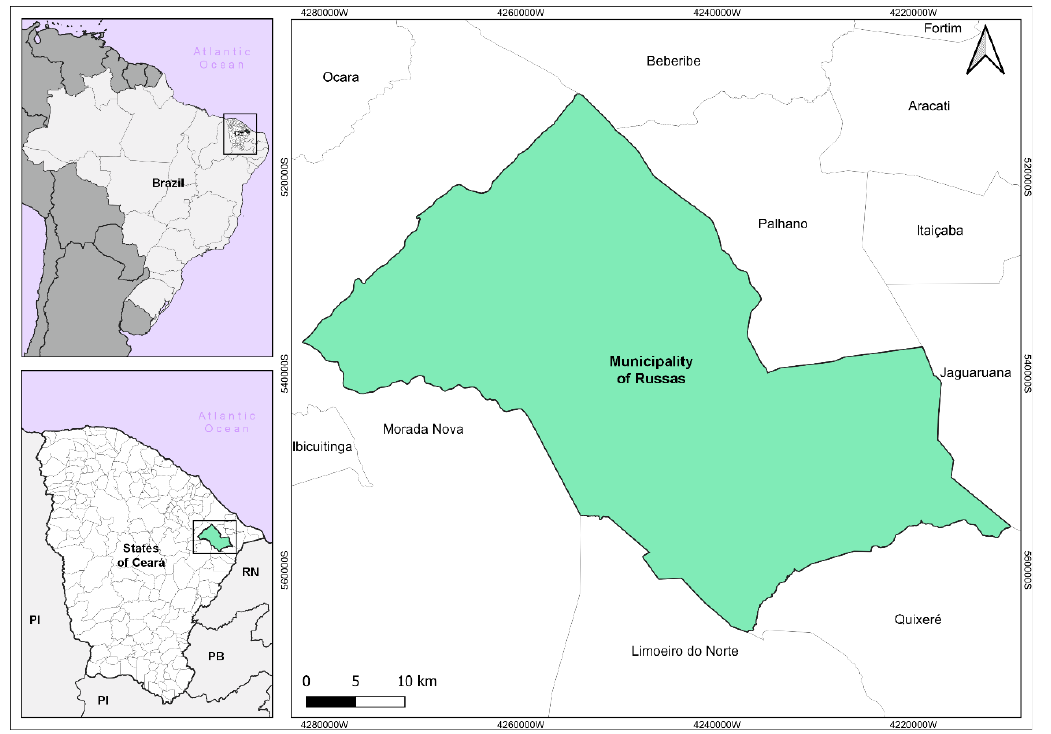
Figure 1. Localization of the municipality of Russas, Ceará, in the northeast of Brazil. The experimental assay was installed in a randomized complete block design, with treatments arranged in split plots with four replications. Plot experimental design was selected depending on three water scenarios: normal, drought, and severe drought. These scenarios were defined based on a 30-year historical series of precipitation data provided by the Foundation for Meteorology and Water Resources of Cear á (Funceme). This series was defined for the municipality of Russas, Cear á , Brazil, for the rainfed farming season in the region (February to May). The subplots were composed of either the provision or lack of supplemental irrigation with treated wastewater and the sub-subplots by the presence or absence of NPK fertilization. Each experimental unit (sub-subplot) was formed by four rows of plants 4.5 m in length.